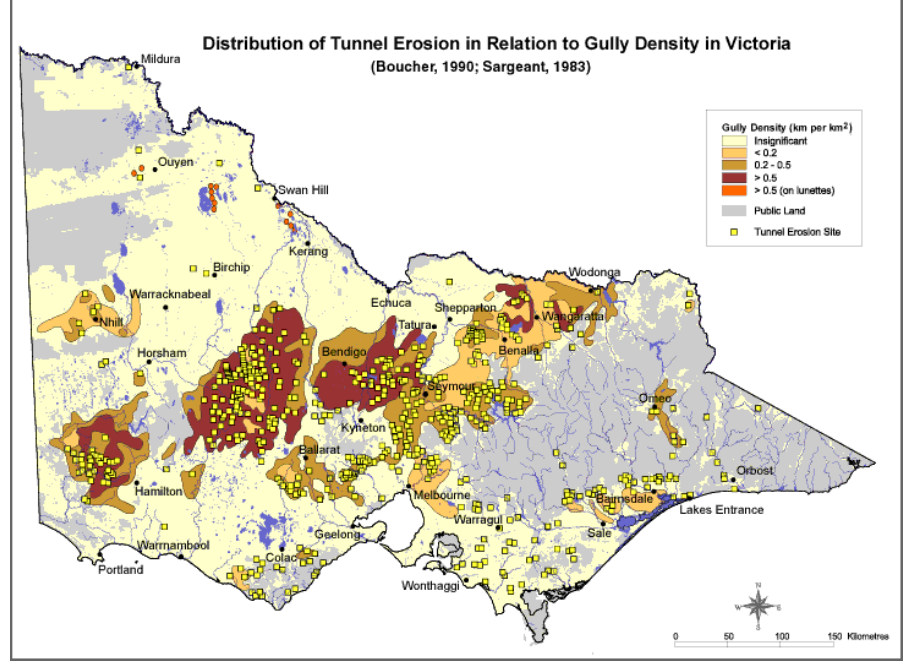
Figure 14. Statewide overview map of gully and tunnel erosion occurrence in Victoria.  State of Victoria, Department of Primary Industries 1997 Reproduced with